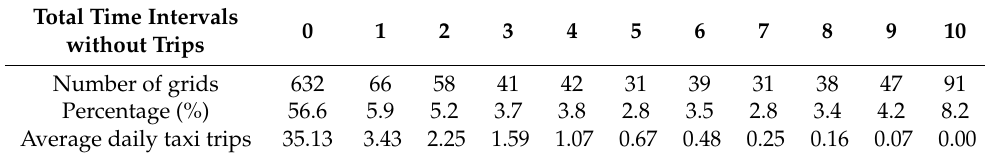
Table 2. Number distribution of grids in terms of the varied taxi trip feature.